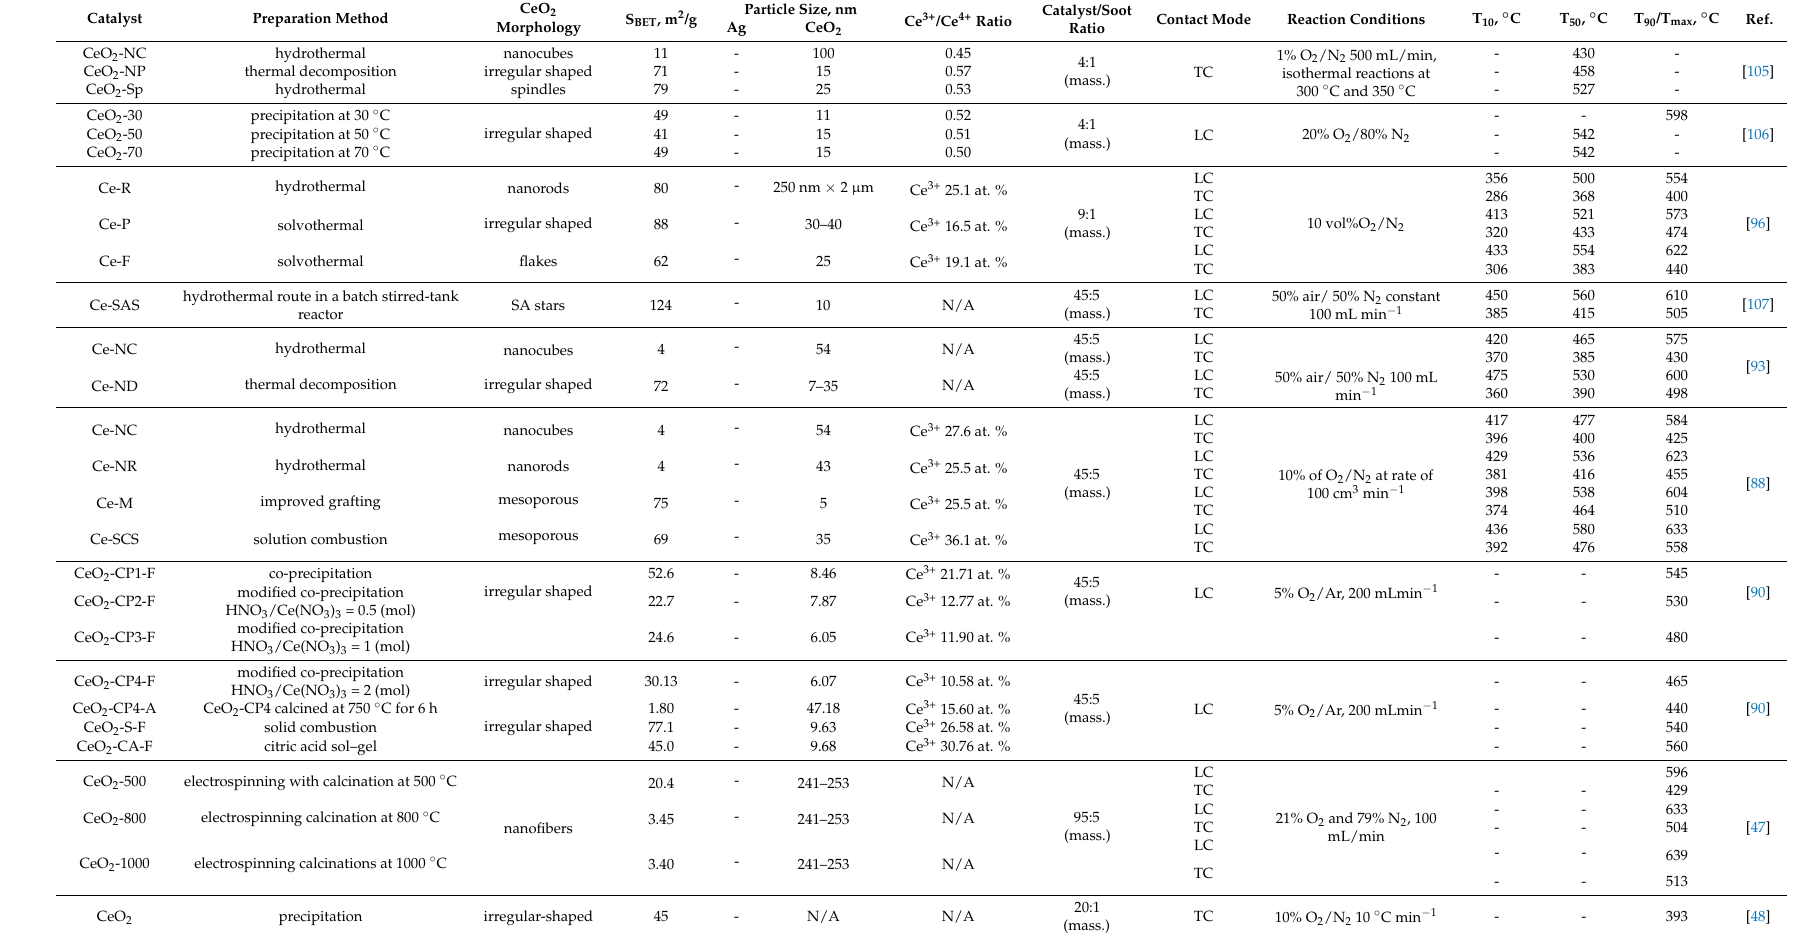
Table 1. A selection of CeO 2 -based catalysts for soot